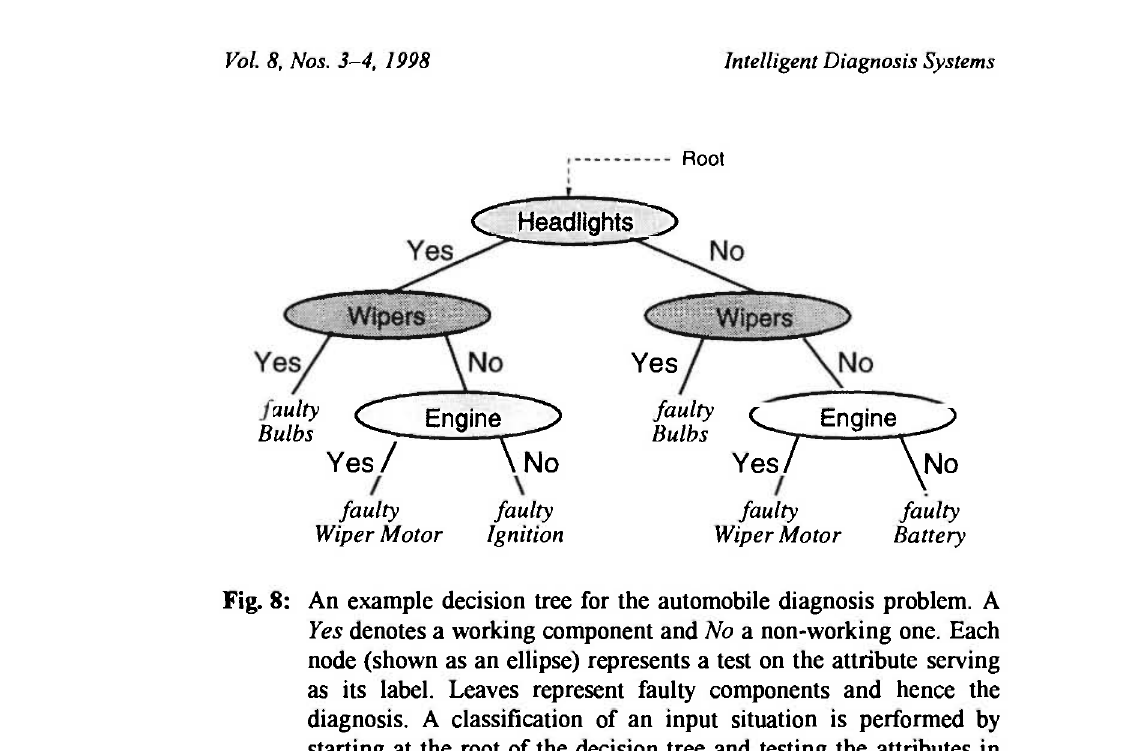
Fig. 8: An example decision tree for the automobile diagnosis problem. A Yes denotes a working component and No a non-working one. Each node (shown as an ellipse) represents a test on the attribute serving as its label. Leaves represent faulty components and hence the diagnosis. A classification of an input situation is performed by starting at the root of the decision tree and testing the attributes in order until a leaf node is reached. The leaf node reached signifies the diagnosis (classification) of the input